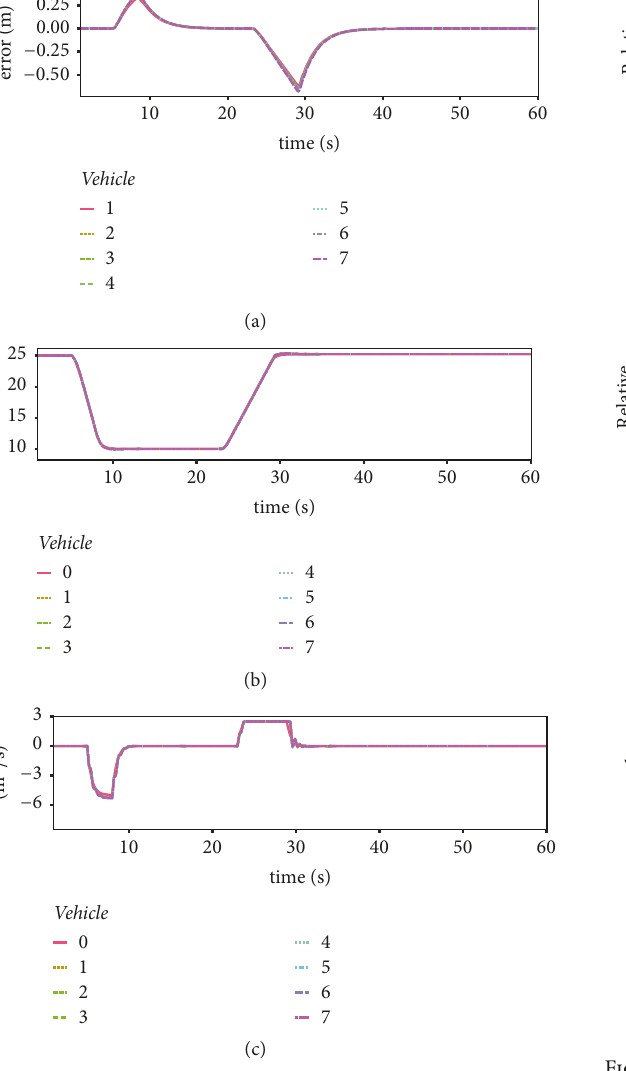
Figure 3: Platoon performance for a single large perturbation scenario: (a) the position error 𝑥 𝑖 (𝑡) − 𝑥 0 (𝑡) + 𝑖 ⋅ 𝑠 ; (b) speed; (c) acceleration.